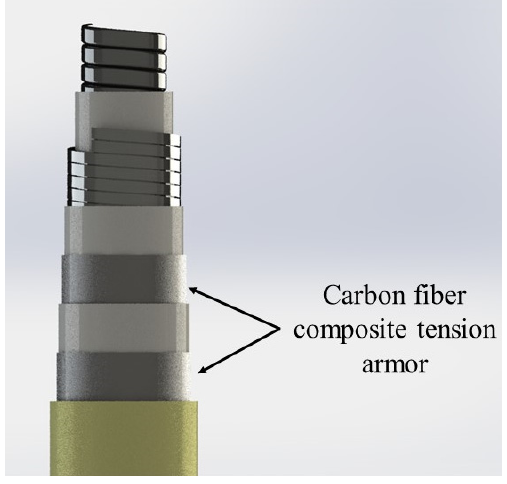
Figure 3. Flexible riser with carbon fiber composite tension armor.